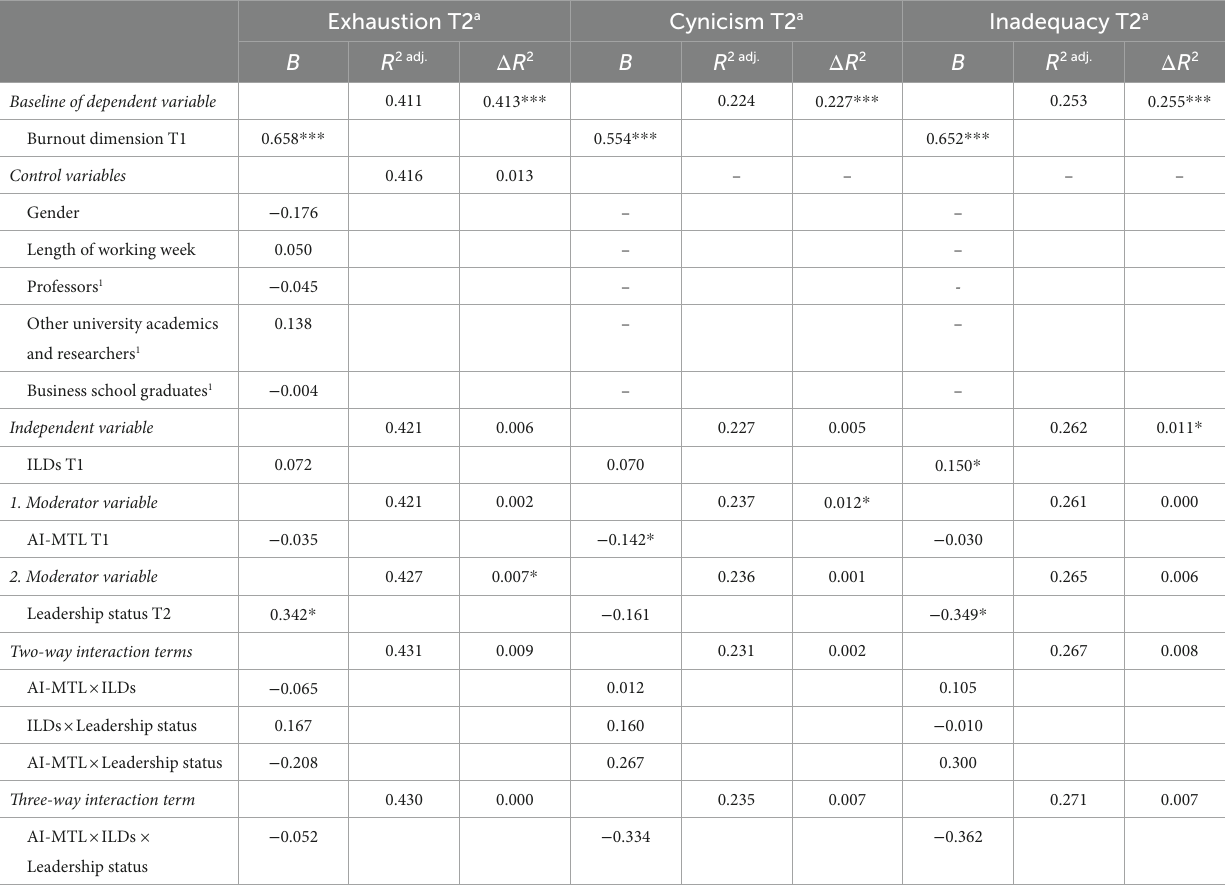
TABLE 4 The longitudinal associations between intensified learning demands (ILDs) and burnout (exhaustion, cynicism, and inadequacy) moderated by affective-identity motivation to lead (AI-MTL) and leadership